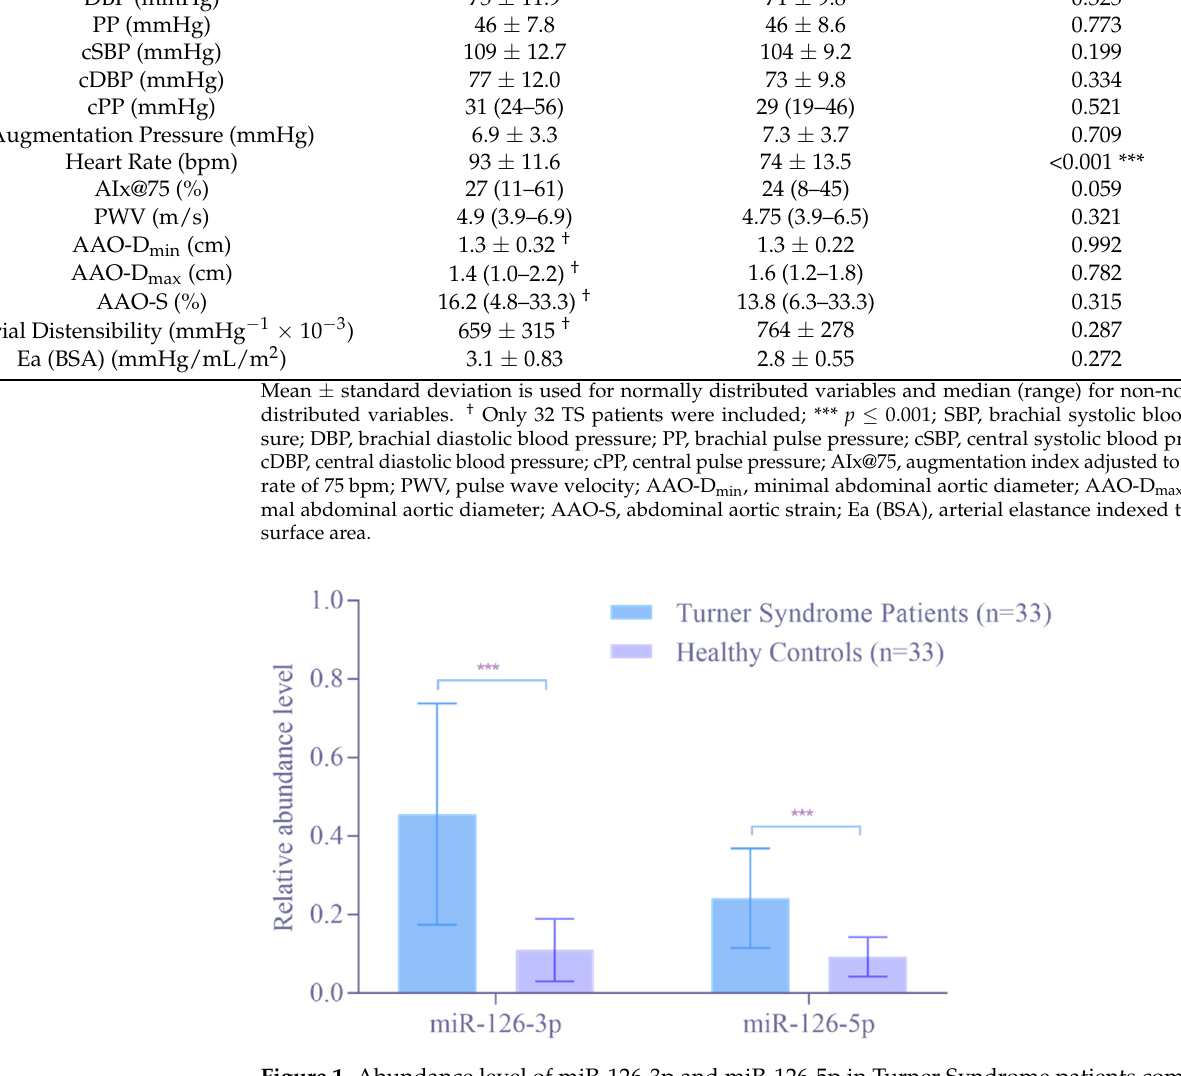
Figure 1. Abundance level of miR-126-3p and miR-126-5p in Turner Syndrome patients compared to healthy volunteers as determined by RT-qPCR. The mean relative abundance level (2 − ∆ Ct ) of all Turner Syndrome patients and healthy volunteers. RNAU6B was used as an endogenous control for the normalization of miRNA. Unpaired Student’s t -test and mean ± standard deviation were used to evaluate differences in abundance levels. *** p ≤